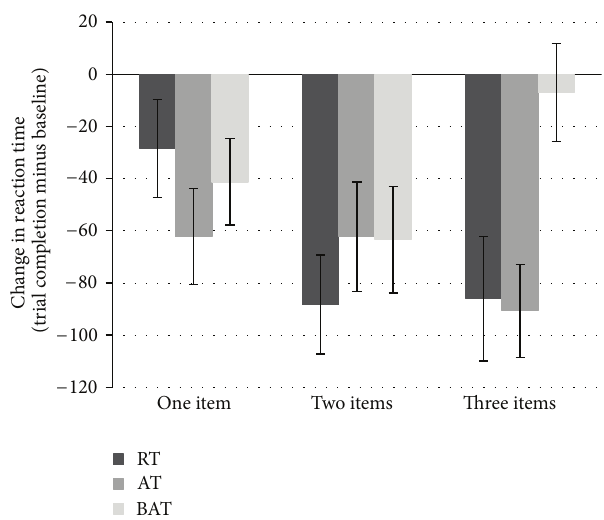
Figure 3: Change between baseline and trial completion on the spatial memory task as a function of number of items presented and exercise group. Both the RT and AT groups showed improved performance compared to the BAT group for the memorization of three items. Error bars represent standard error of the mean.